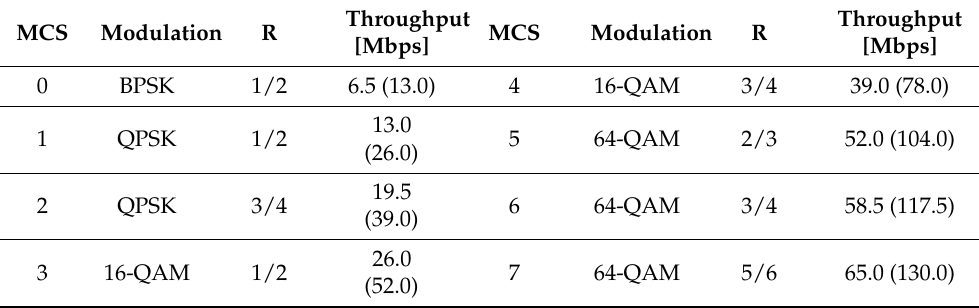
Table 1. Modulation and throughput for each of the modulation and coding scheme (MCS)